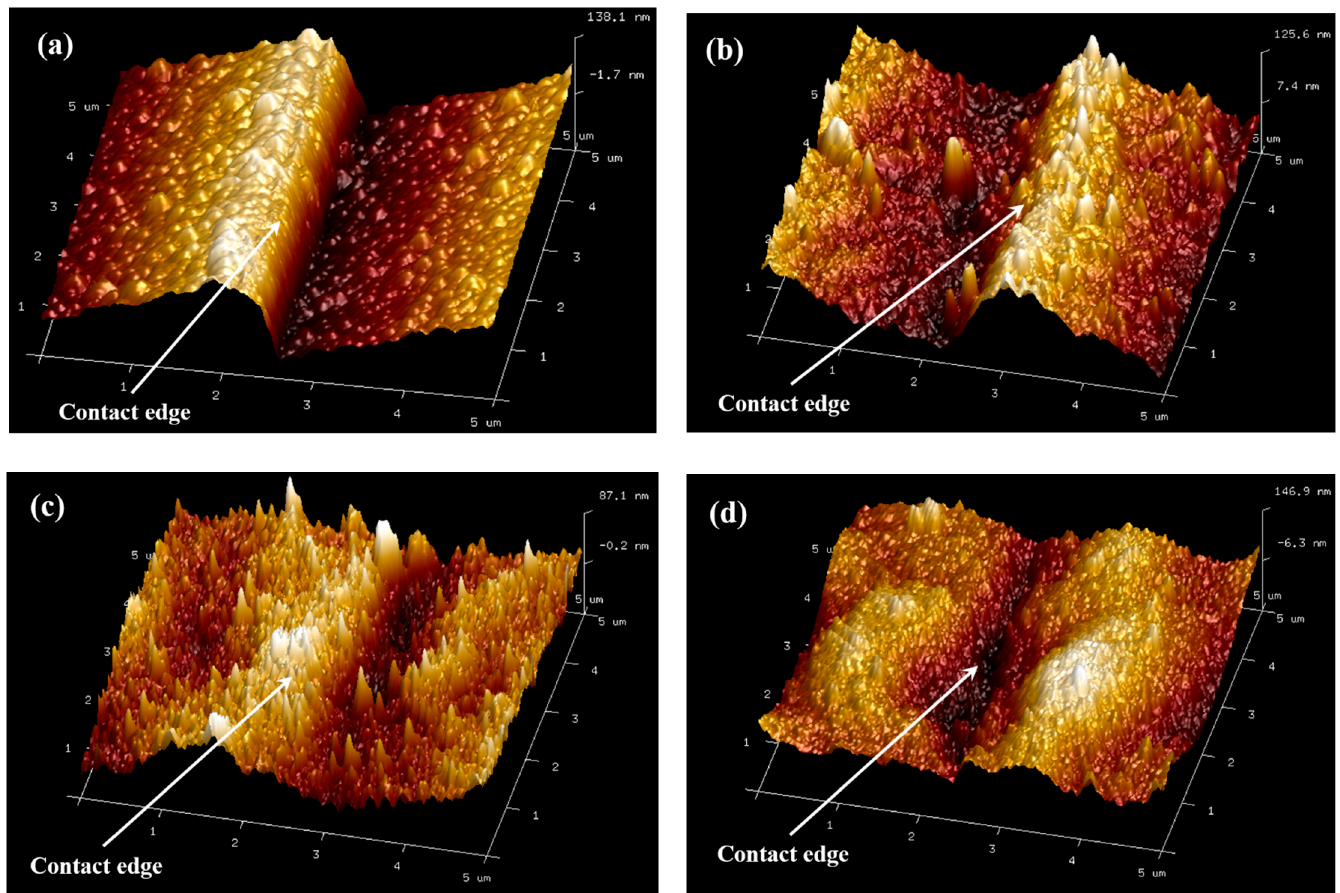
Figure 12. The morphology of the contact edge between the metal electrode and the side of the epitaxial layer, measured by AFM with the scanning area of 5 × 5 µ m, after annealing at the temper- ature of ( a ) 700 °C, ( b ) 750 °C, ( c ) 800 °C, and ( d ) 850 °C.